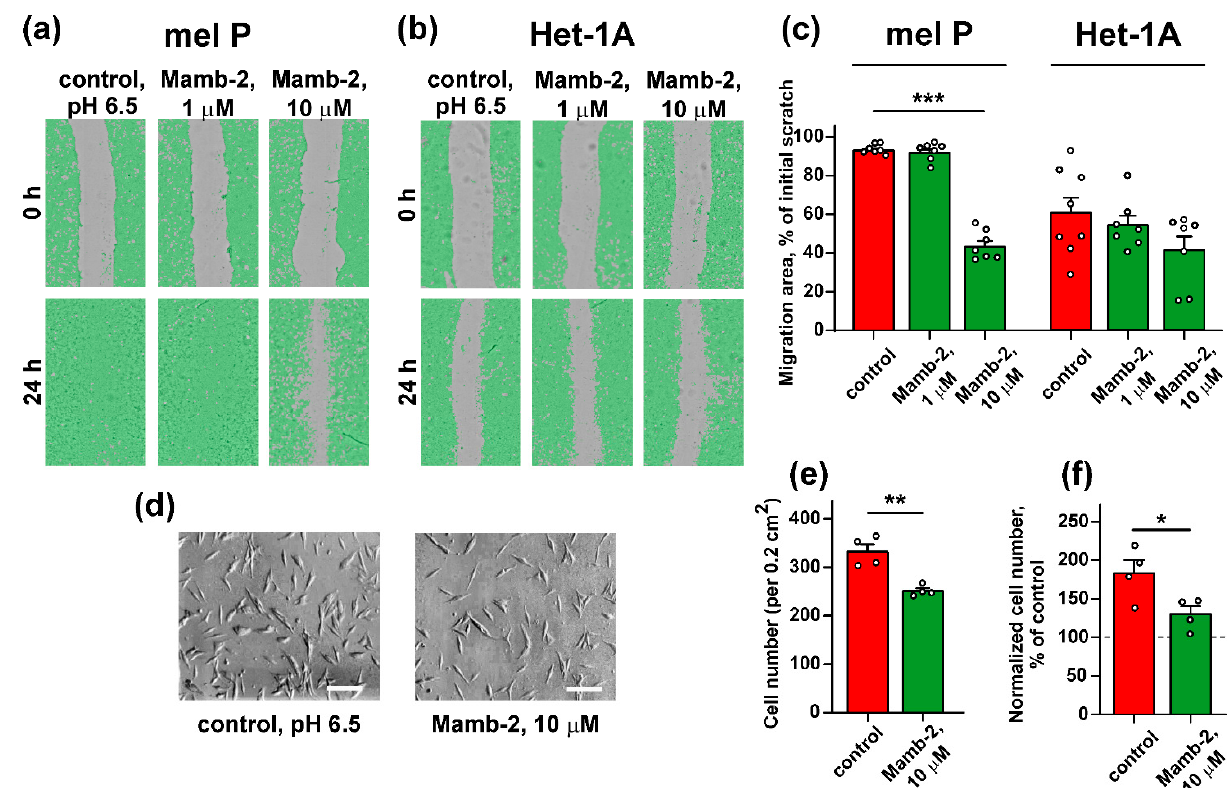
Figure 6. Influence of mambalgin-2 on mel P and Het-1A cell migration and invasion: ( a,b ) representative pictures of scratch test for mel P ( a ) and Het-1A ( b ) cells incubated at pH 6.5 in absence or presence of mambalgin-2; ( c ) scratch square occupied by migrating mel P and Het-1A cells incubated at pH 6.5 in absence or presence of mambalgin-2. Data are presented as % of the scratch surface, occupied by migrating cells ± SEM ( n = 7–8), *** ( p < 0.001) indicates significant difference between data groups by One-Way ANOVA followed by Tukey’s post hoc test; ( d ) representative phase-contrast images showing mel P cells migrated through the 8 µ M pore bottom of the migration chamber upon cultivation at pH 6.5 in absence or presence of mambalgin-2 ( × 100 magnification, scale bar = 20 µ m); ( e ) number of mel P cells migrated through the 8 µ M pore bottom of the migration chamber upon cultivation at pH 6.5 in absence or presence of mambalgin-2. Data presented as the number of cells per 0.2 cm 2 ± SEM ( n = 4). ** ( p < 0.01) indicates significant difference from the data groups by two-tailed t -test; ( f ) number of migrated mel P cells cultivated at pH 6.5 in absence or presence of mambalgin-2 assayed by the WST-1 test and normalized to the number of migrated cells cultivated at pH 7.4 in absence of mambalgin-2 (shown by dashed line). Data are normalized cell number ± SEM ( n = 4). * ( p < 0.05) indicates significant difference between the data groups by two-tailed t